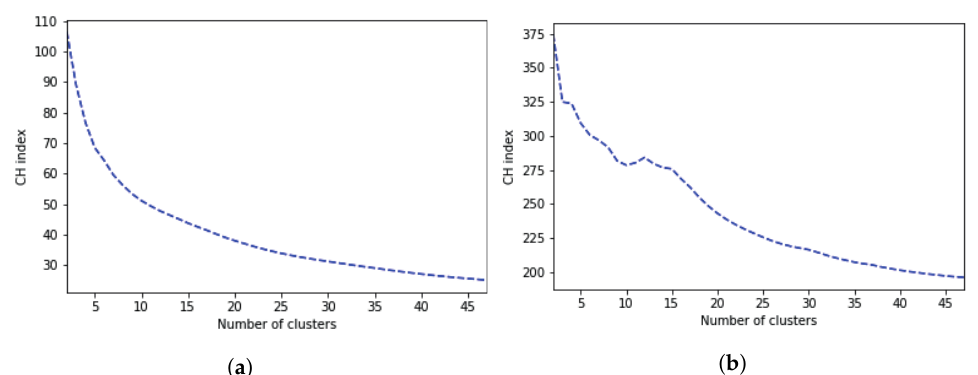
Figure 15. Search for the number of clusters. ( a ) SN forecast. ( b ) RNN forecast.